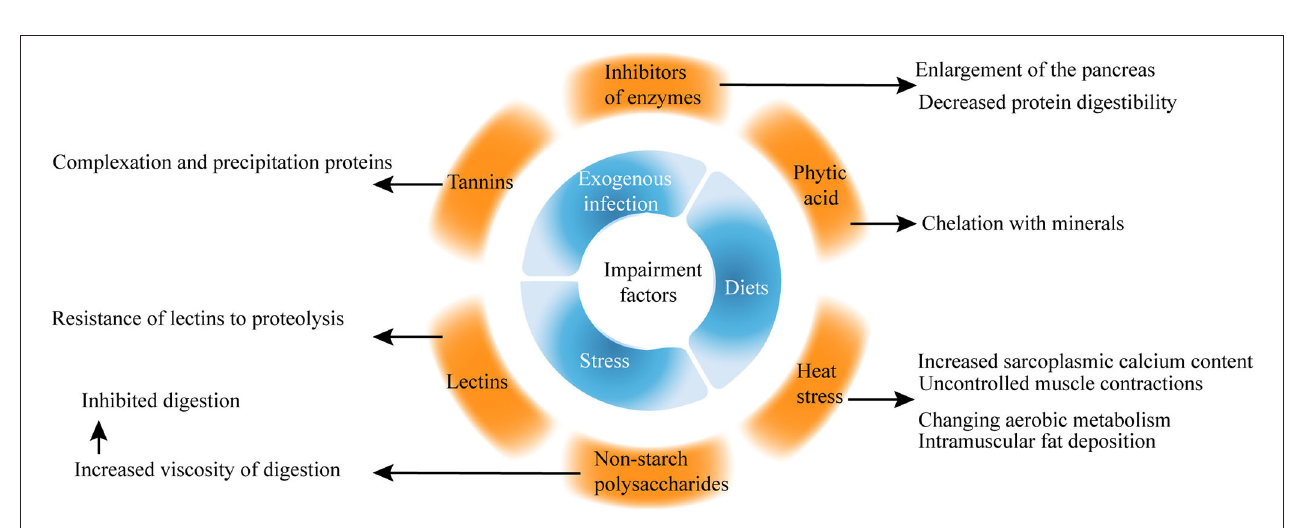
FIGURE 3 | Impairment factors of gut health in